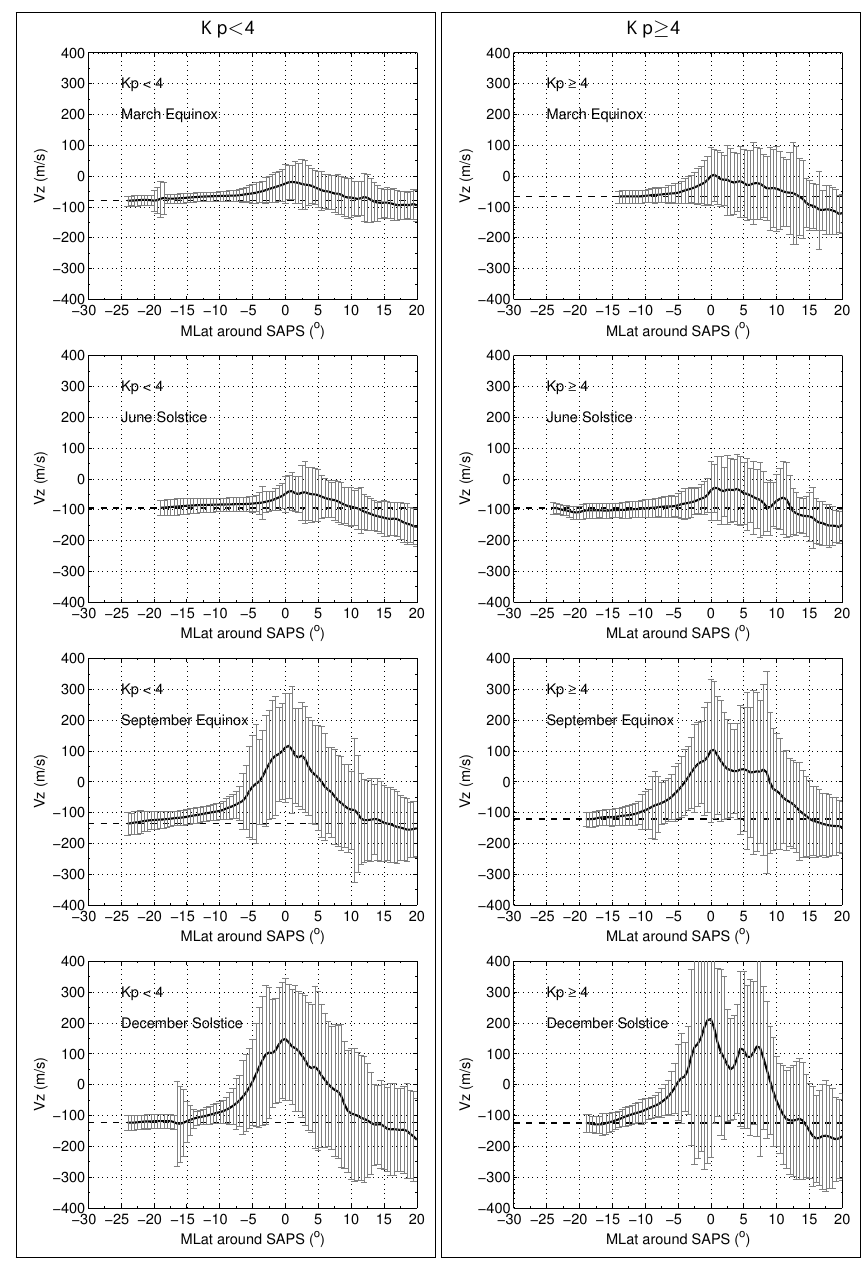
Fig. 3. The same as Figure 2, but for the vertical flow velocity. Positive values denote upward flow velocity. The background velocity is indicated by a dashed line.